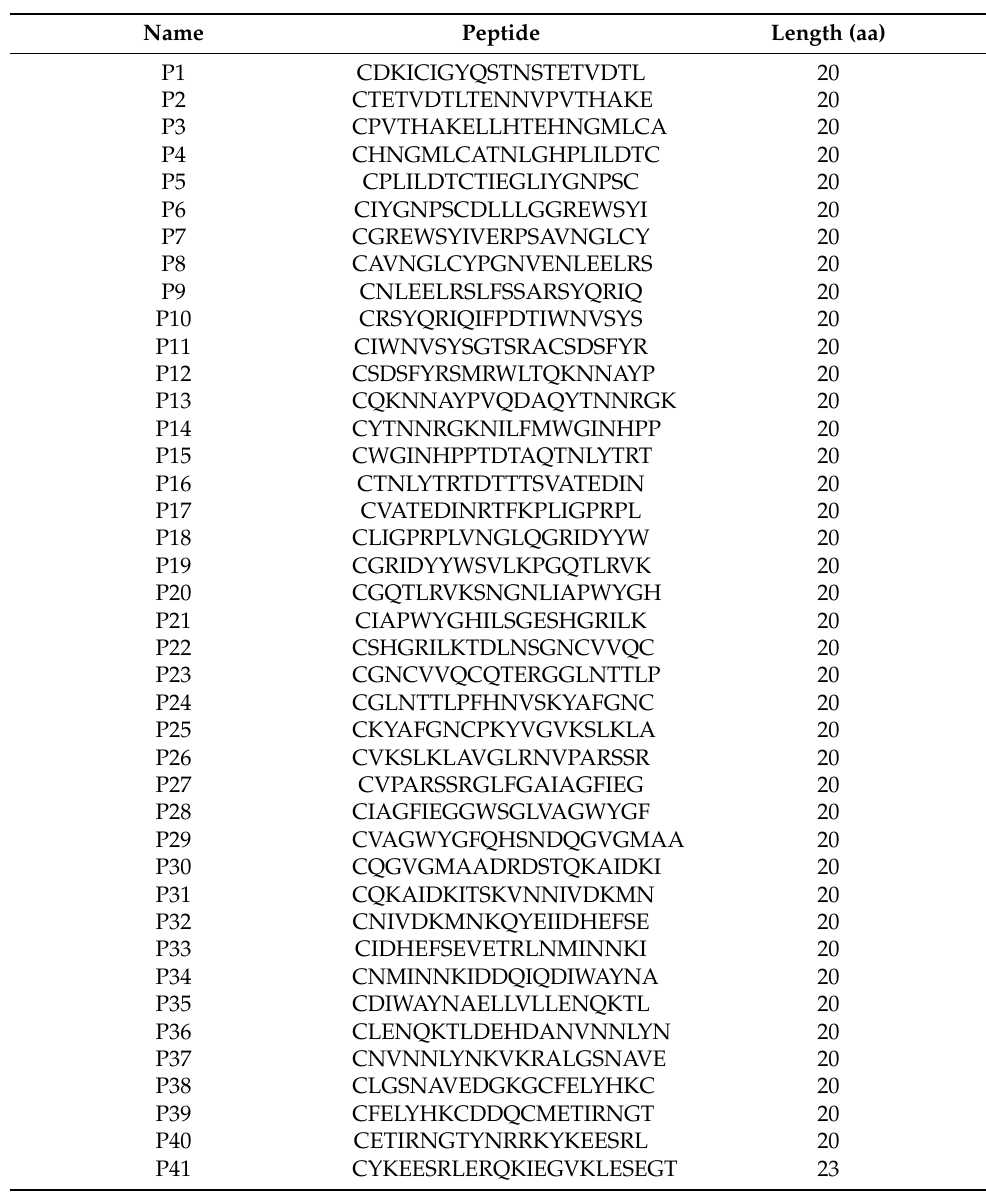
Table 1. Amino acid sequence of peptide P1–P41.